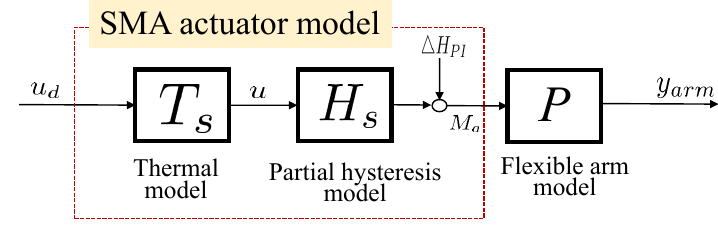
Figure 3. Interactive SMA actuator